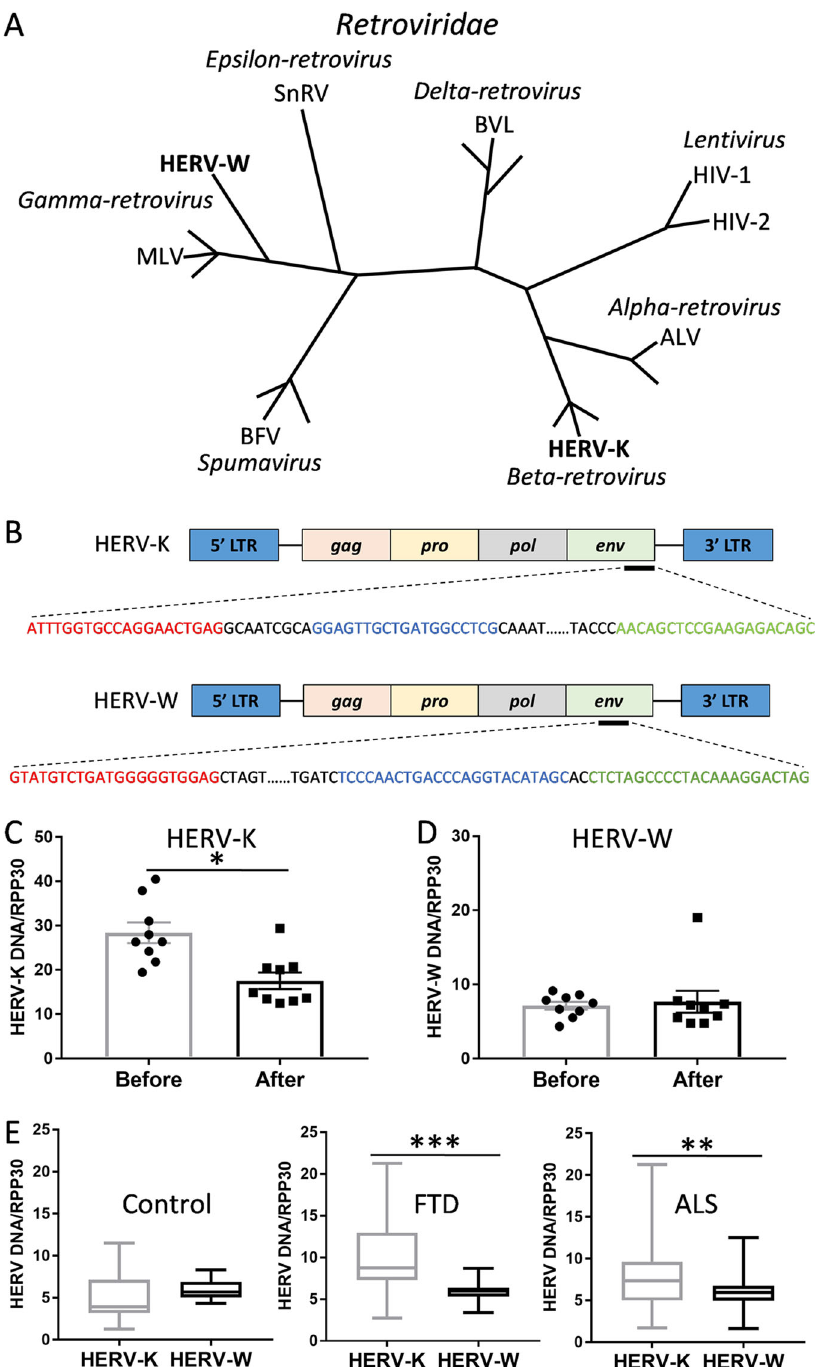
Fig. 1 Validation of HERV-K measurements of a clinical trial data. A Phylogeny of Retroviridae family with HERV-K and HERV-W belong to different genera (italicized) (adapted from Weiss et al. 24 ). B ddPCR ampli fi cation of the HERV-K and HERV-W env gene with forward primer (red), reverse primer (green) and probe (blue). C Validation of the antiretroviral drug Triumeq effect on HERV-K levels before and after 24 weeks of treatment in ALS patients ( n = 9). Data represent individual patients, mean and SE as error bars. D HERV-W levels before and after 24 weeks of treatment with Triumeq in ALS patients ( n = 9). Data represent individual patients, mean and SE as error bars. E A comparison of HERV-K and HERV-W env levels in control ( n = 21), FTD ( n = 63) and ALS ( n = 89) serum. Data represent median with min and max as whiskers. * P < 0.05, ** P < 0.001, *** P <